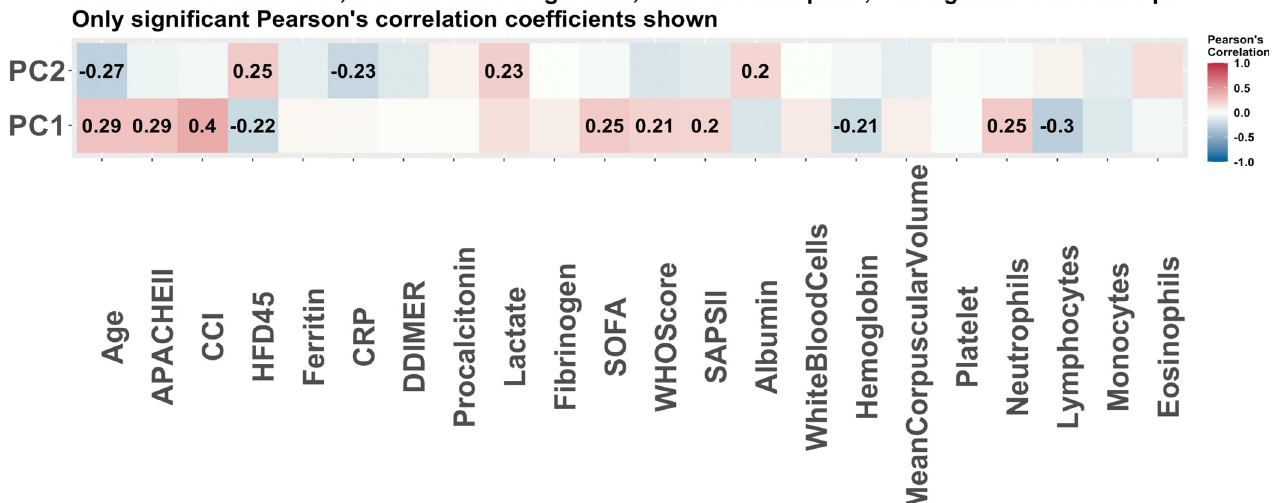
Fig 5. The Pearson correlations of principal components of pathways associated with disease status. The Pearson correlations of clinical covariates and the principal components used to summarize the enriched pathways with COVID-19 status as predicted by LIPEA. These are the pathways predicted to be enriched based on the 9 lipids determined to be associated with COVID-19 status via stability selection. Only the correlations which were significant (p- value < 0.05) are reported. The strongest correlation is with the Charlson score.